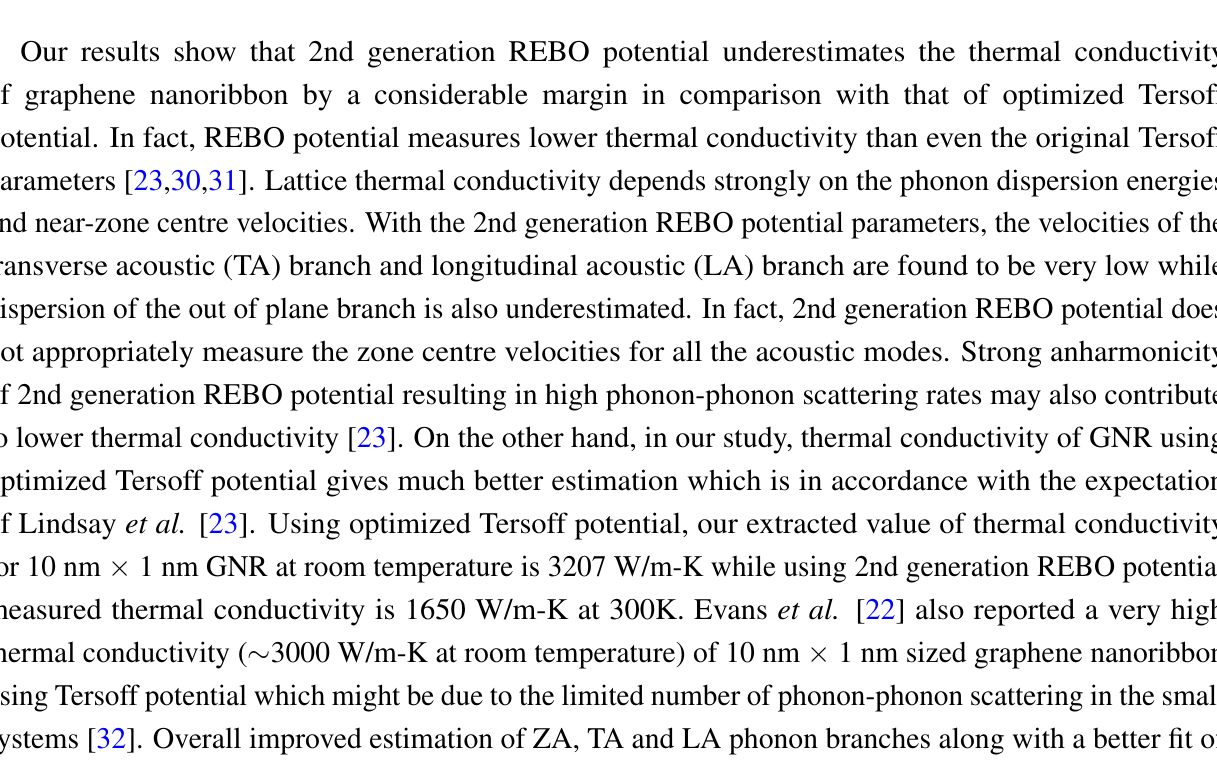
Figure 3. Schematic atomic structure of 10 nm × 1 nm zigzag